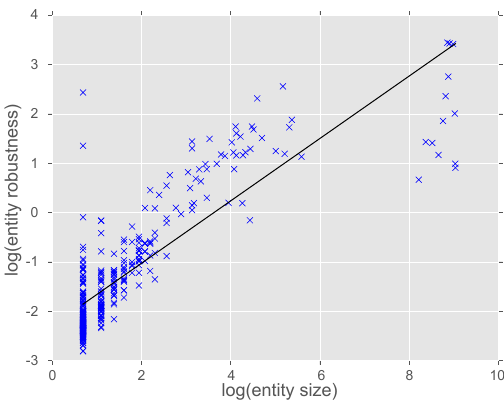
Figure 3. Correlation of entity size and robustness score. Entity robustness is calculated based on network support from co-expression data and from bootstrap analysis. There is a strong positive correlation between entity size and robustness ( R = 0.84, p (cid:28)